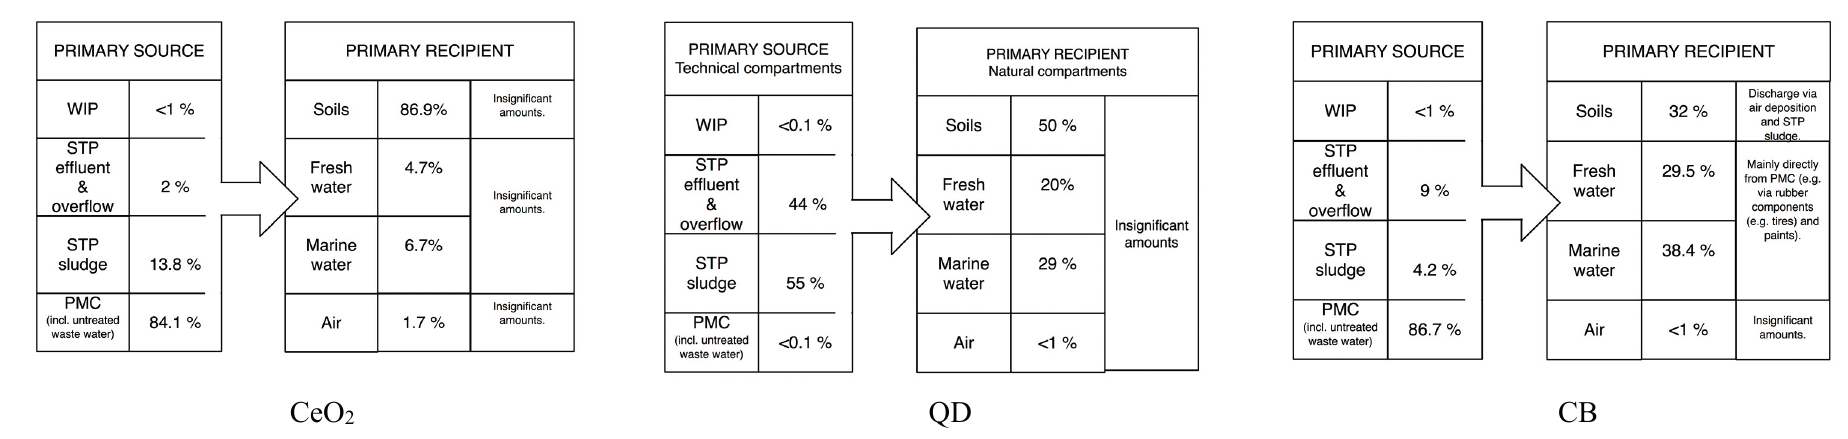
Figure 3. Overview of the most important ENM sources and receivers. The percentages show the most frequently modeled results (modal values). Table 2. Concentration of the nine nanomaterials in natural and technical compartments. Mode value and 95% interval are shown, all rounded to two significant numbers. The values for environmental sinks (soils, sediment) represent masses in 2014 accumulated since the year 2000.